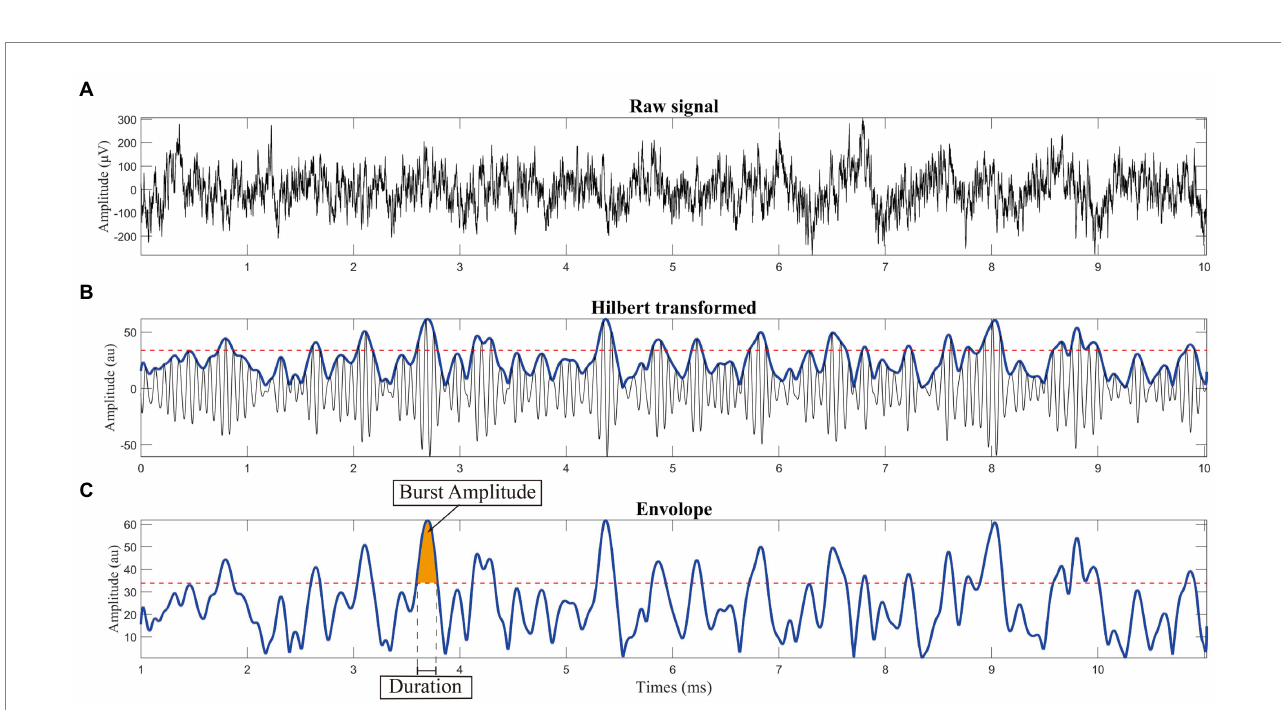
FIGURE 2 Schematic diagram of burst analysis. (A) Raw signal recorded from the subthalamic nucleus using microelectrode recoding. (B) Calculating the envelope: we used the Hilbert transform with a 6 Hz bandwidth centered around the selected peak frequency (peak frequency is shown in Figure 1A). (C) Threshold was defined in terms of the 75th percentile of the Hilbert envelope amplitude, as shown by the red dashed line. Burst was identified as wavelet amplitude exceeding the applied amplitude threshold. Burst duration was defined by the time points at which the selected time evolution of the wavelet amplitude exceeded a given amplitude threshold. To reduce the contribution of other noise, bursts with durations shorter than 100 ms were excluded before further